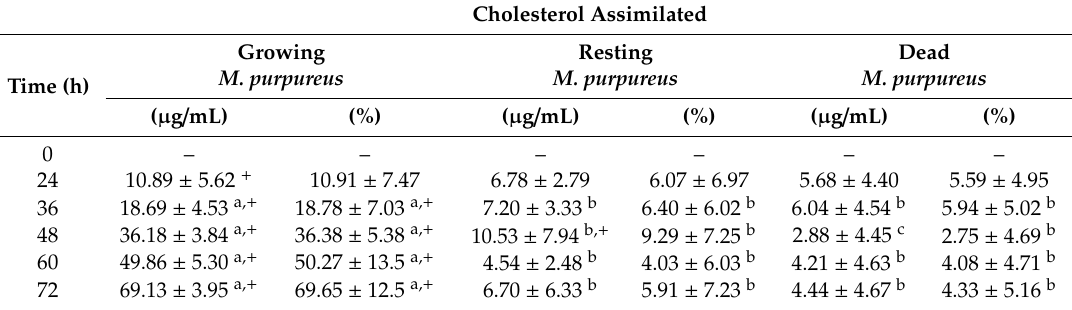
Table 1. Cholesterol assimilated in M. purpureus CBS 109.07 at di ff erent growth phases. All cultures